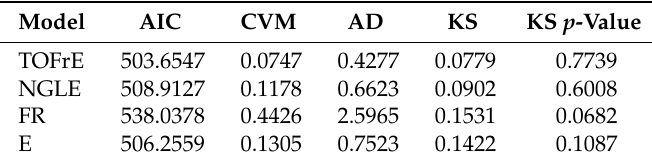
Table 11. Numerical measures of fitness of the models for Data set II.